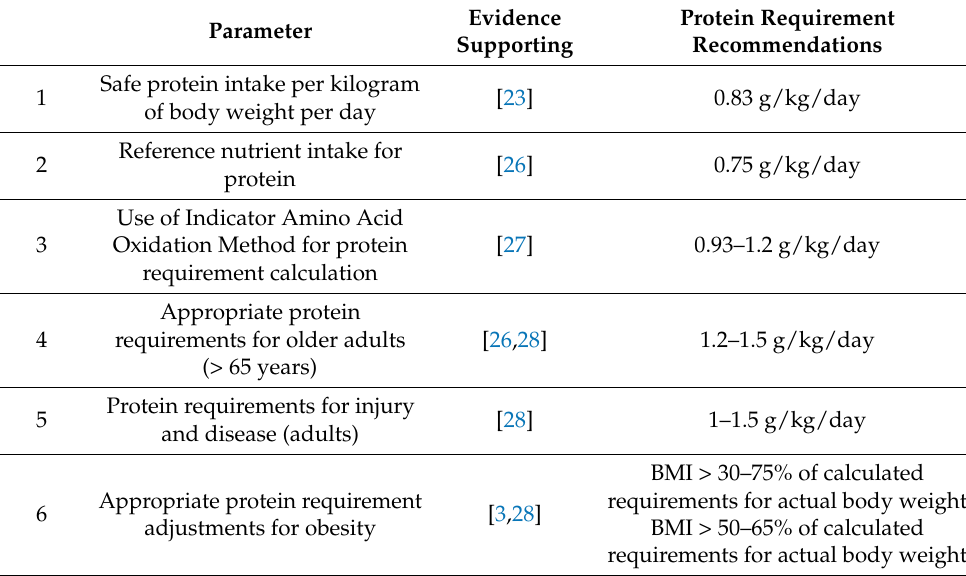
Table 1. Outlining different ways of calculating protein requirements in